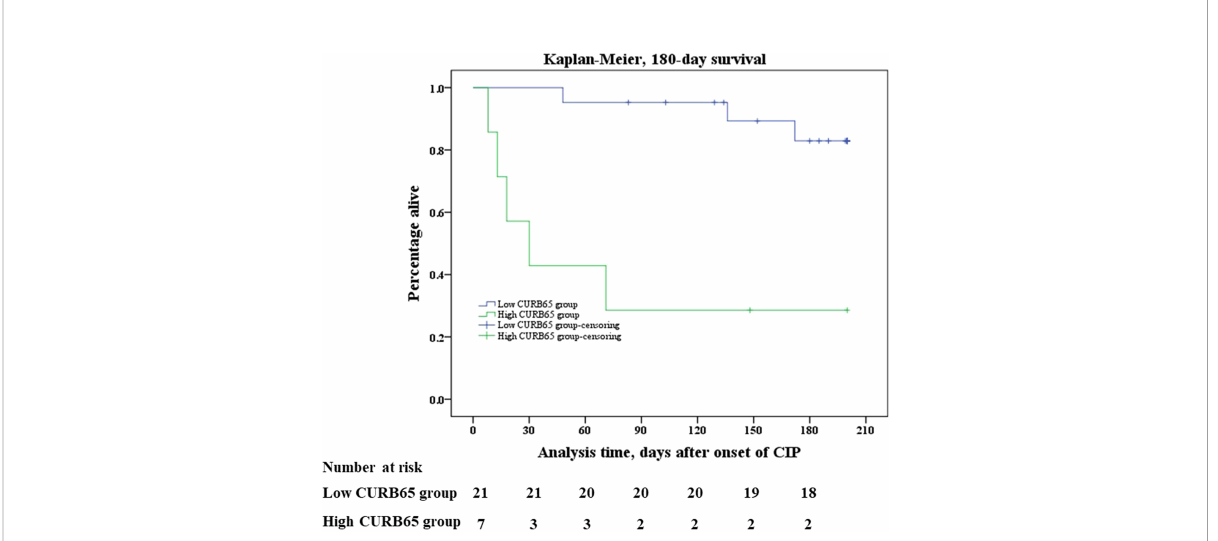
FIGURE 2 Kaplan – Meier survival analysis. Kaplan – Meier analysis of survival in 180 days after onset of CIP showed that mortality was signi fi cantly higher in the high-CURB65 group than in the low-CURB65 group (log rank, p < 0.001). CURB65, consciousness, urea nitrogen, respiratory rate, blood pressure and age; CIP, checkpoint inhibitor-associated